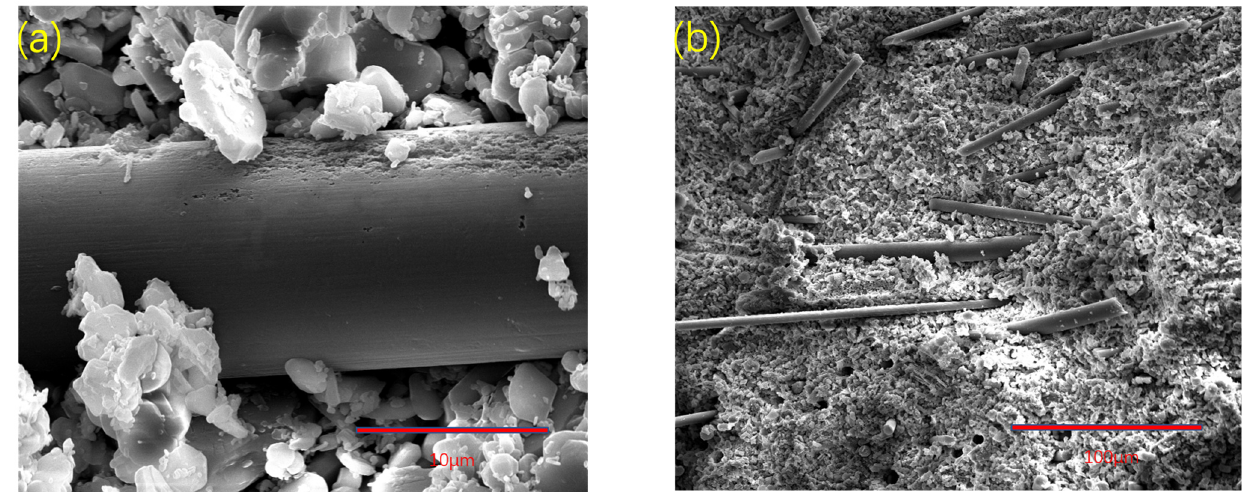
Figure 8. The 3D-printed SEM images of fracture of group F samples of alumina composite ceramics: ( a ) with 5000× magnification and a scale of 10 μ m, the fiber surface partially corroded; ( b ) with 500× magnification and a scale of 100 μ m, the fiber arrangement was chaotic, and some were densely stacked.